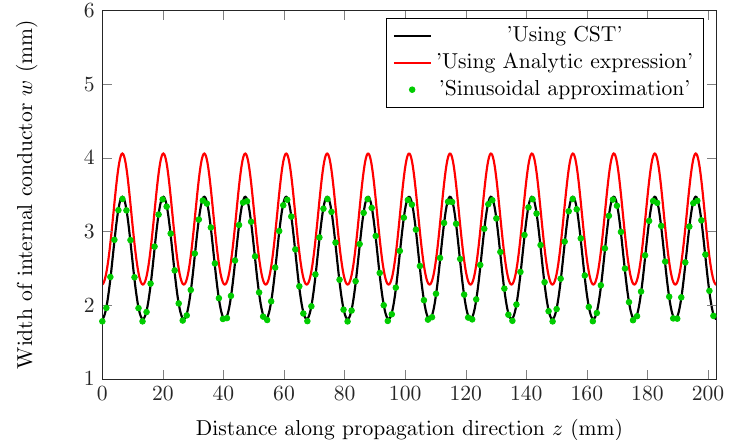
Figure 6. Width of the internal conductor of the ESICL ( w ) that provides the desired coupling coefficient. After 450 iterations, an optimization process with the Nelder Mead simplex algorithm [35] determined the optimum values of the parameters A w , B w and P for an optimum match of this sinusoidal approximation with the accurate value of w ( z ) . It gave A w = 0.8305, B w = 2.61103 and P = 3.0817. This approximation, which matches almost perfectly with the accurate value, was − preferred to the accurate one, because it eases the modeling and simulation of the ESICL continuous profile filter in the electromagnetic